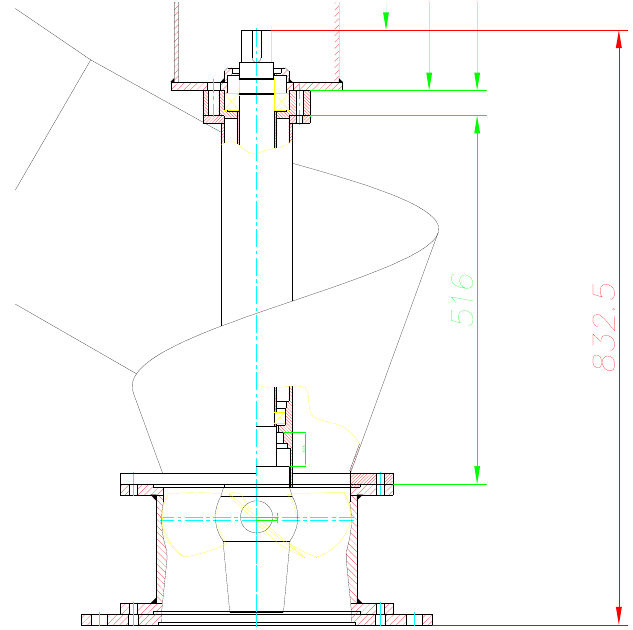
Figure 10. A cross-section of the segment of the water inlet system to the runner and the runner segment of the model semi-Kaplan turbine.